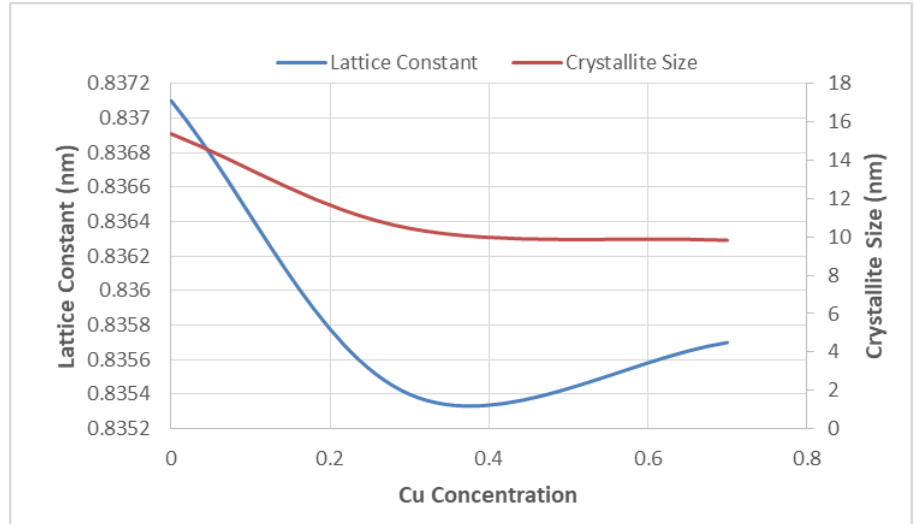
Fig.6: Variation of lattice constants and crystallite size with Cu +2 ions concentration.